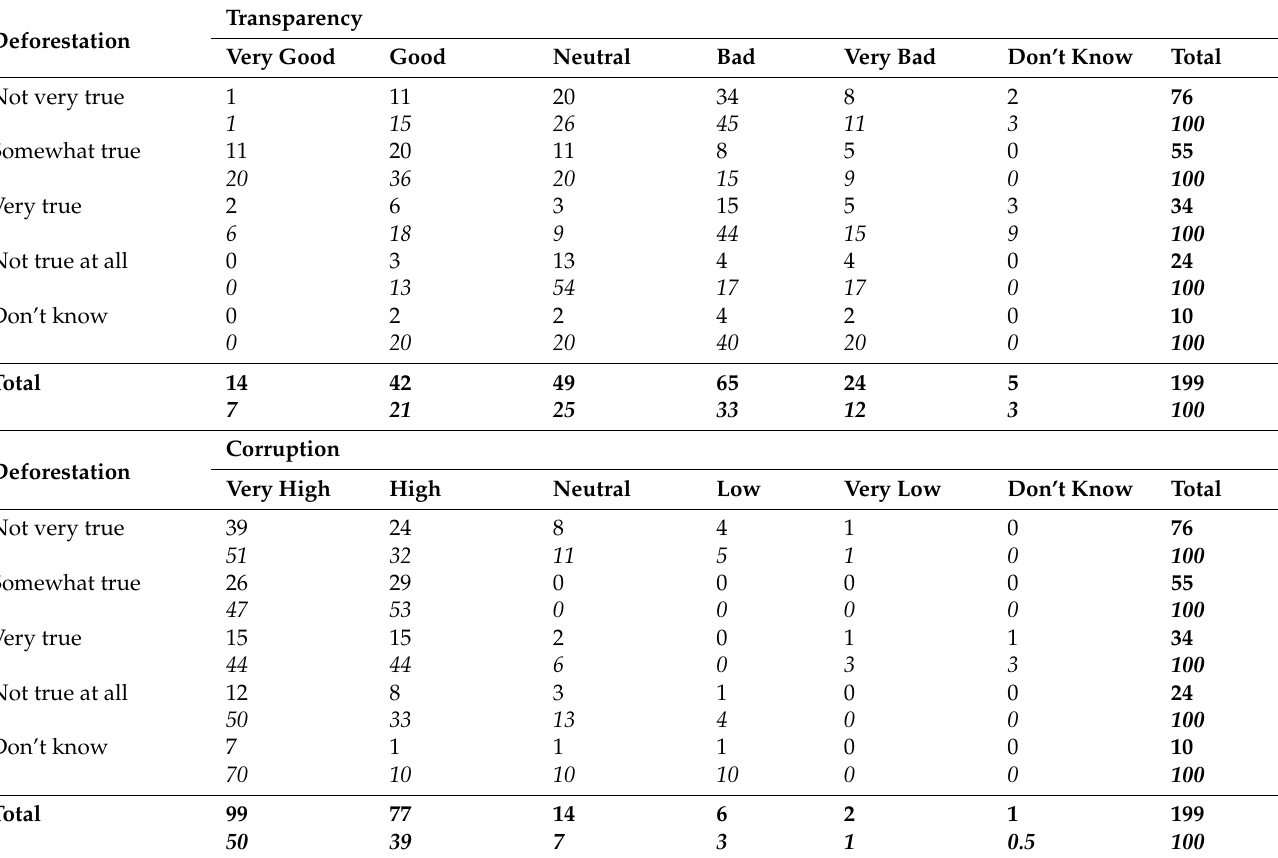
Table 2. Deforestation and